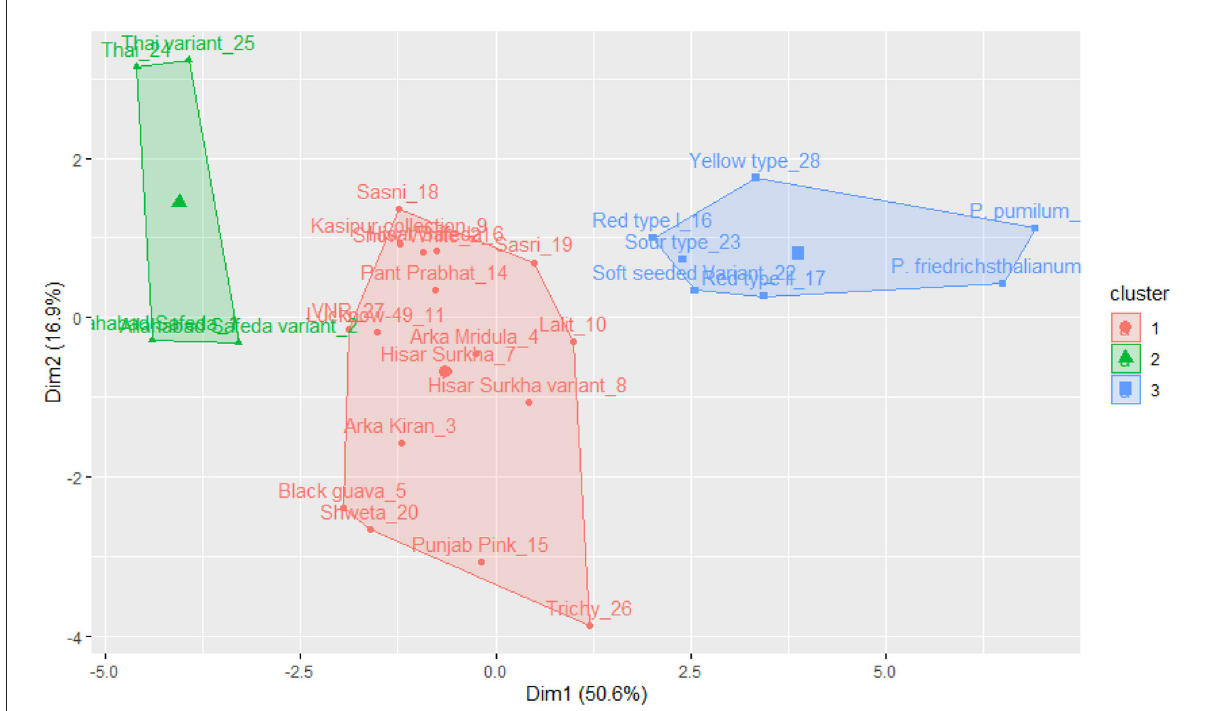
FIGURE5 K-means cluster solutions plotted against the PCA scatter plot (component 1 on the X axis and component 2 on the Y axis, k-3) based on the 16 quantitative